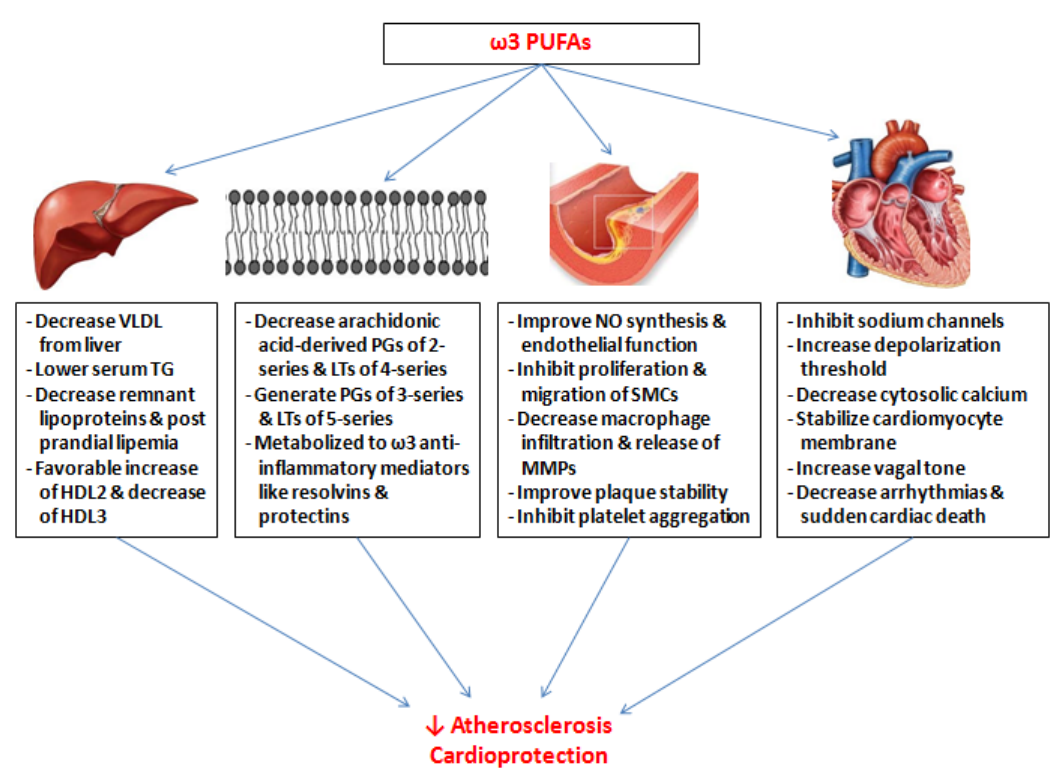
Figure 2. Pleiotropic cardioprotective effects of ω -3 PUFAs.